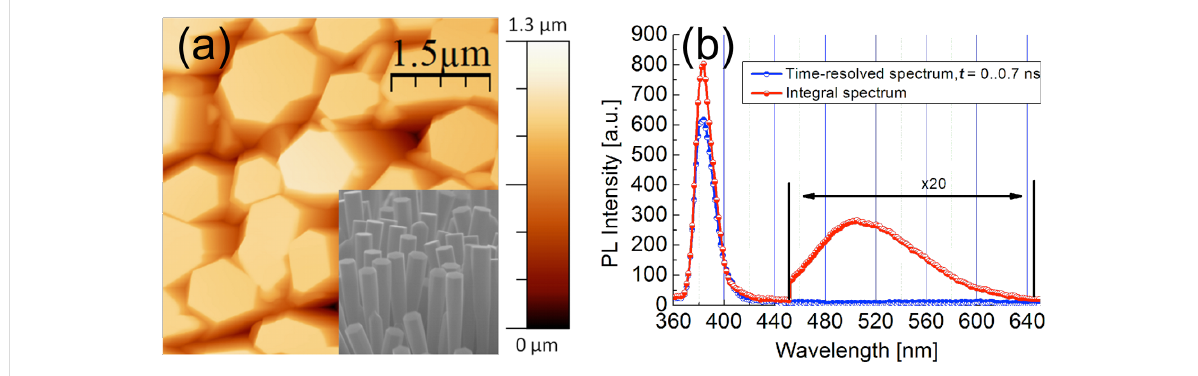
Figure 2: (a) 5 μ m × 5 μ m intermittent contact mode AFM image and SEM micrograph (inset) of ZnO nanorods grown by thermal evaporation, (b) time-resolved (blue curve) and integral (red curve) PL spectra from the array of upright standing ZnO nanorods, of photoluminescence obtained at 300 K.